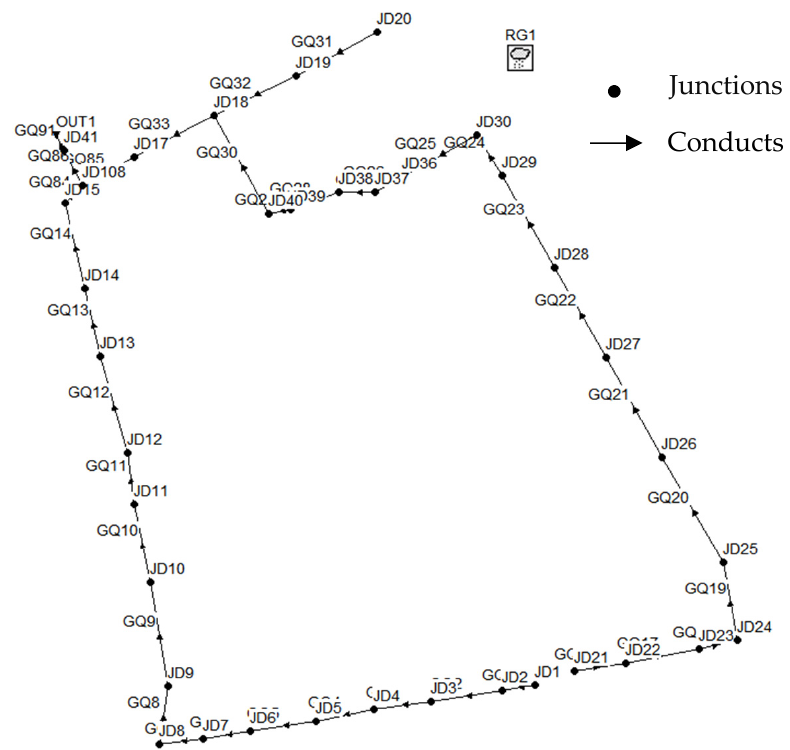
Figure 1. Drainage network.